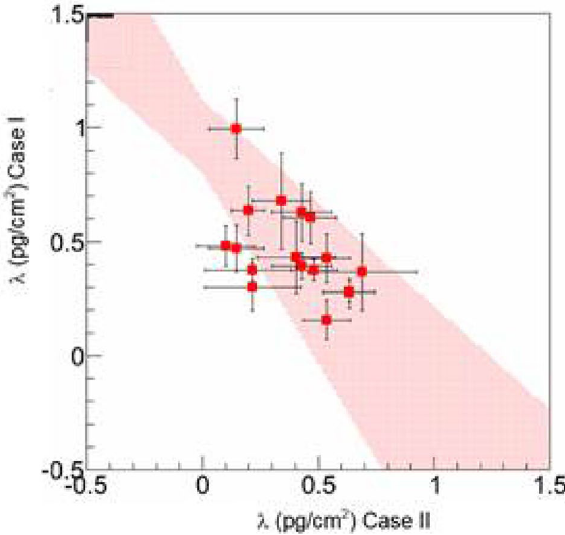
Figure 4. Correlation diagram of lithium area density λ I versus λ II ; Pink colour anticorrelation